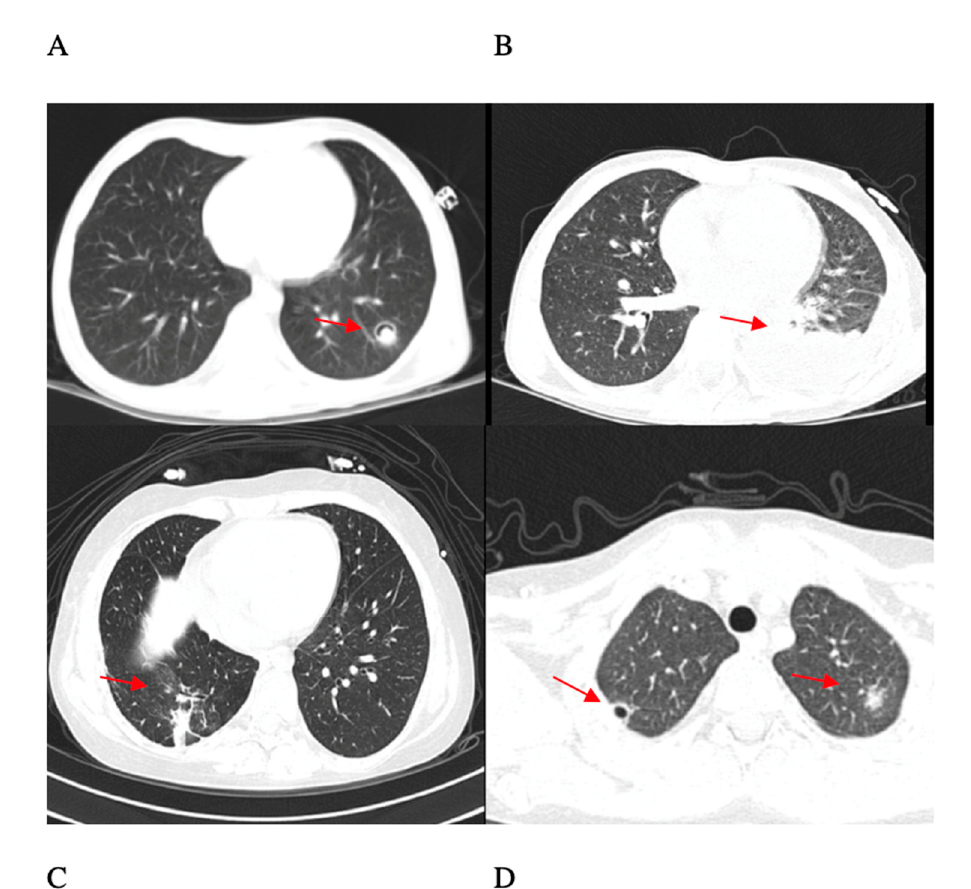
Figure 2. Thoracic CT of patient 1 at day 21 ( A ) and day 35 with initial worsening ( B ); patient 3 ( C ); patient 5 ( D ). Red arrows show the most evident sites of fungal infection.